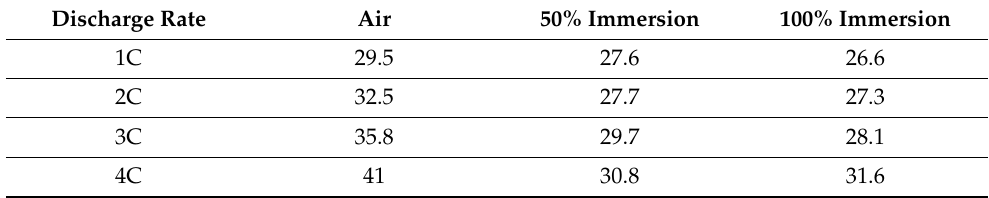
Figure 5. The effect of fluid type and immersion ratio on maximum battery surface temperature for various discharge rates ( a ) 1C, ( b ) 2C, ( c ) 3C and ( d ) 4C (T inlet = 25 °C). Table 3. The minimum temperatures at end of discharge for different operation